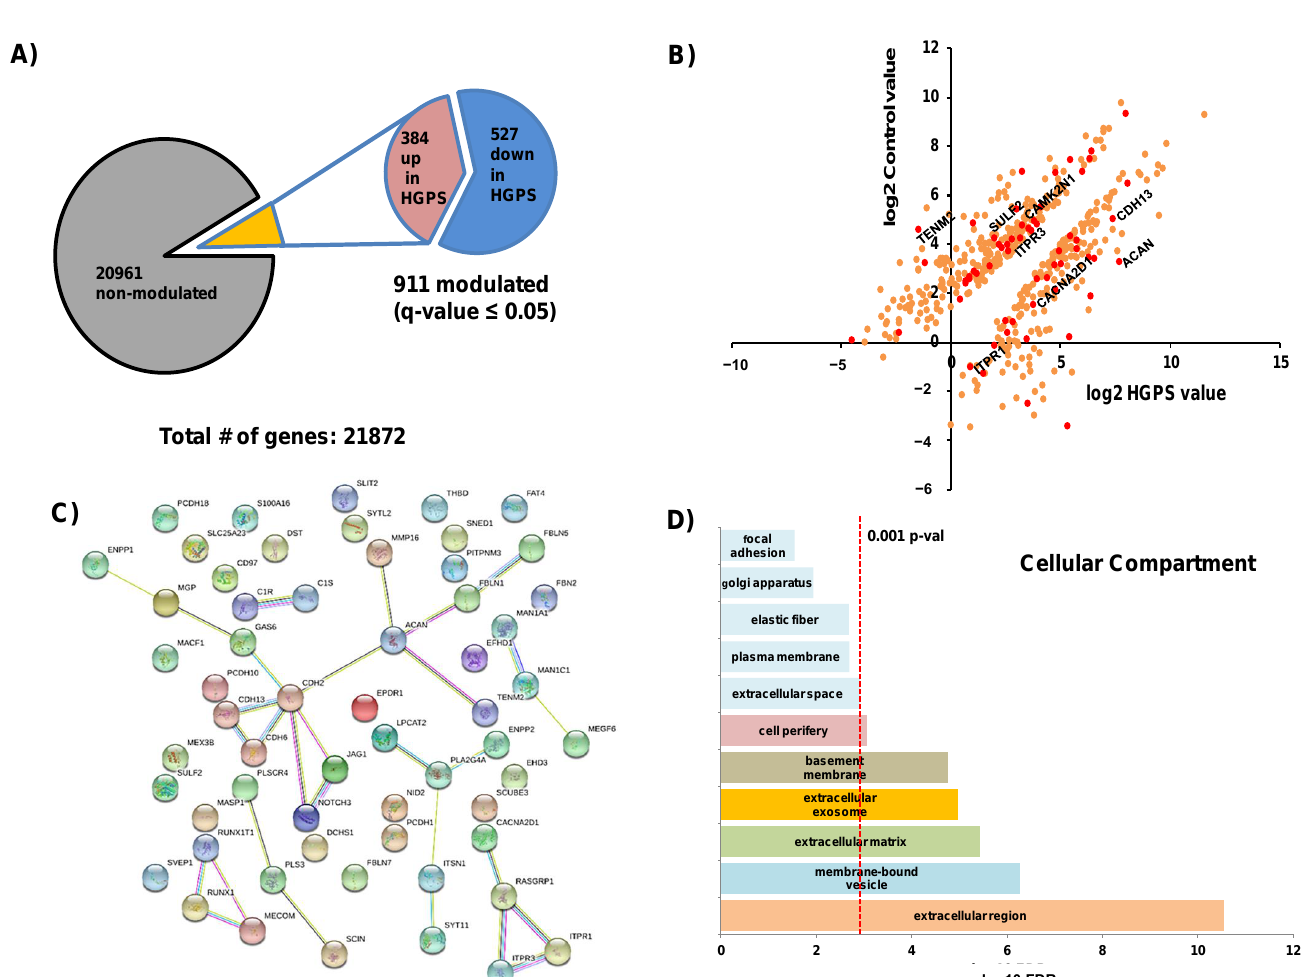
Figure 1. Summary of the massive genomic analysis (RNAseq). ( A ) Summary of the NGS showing the 21,872 different quantified transcripts. Of these, 911 were considered to be significantly modulated, with q -values ≤ 0.05. ( B ) Representation of the values for the 911 significantly modulated transcripts and those coding for Ca 2+ flux-related proteins (in red). ( C ) String 10.1 pathway analysis for the Ca 2+ flux-related transcripts showing the interaction networks. ( D ) Statistical analysis shows that most of those transcripts codify for extracellular and membrane-bound (vesicle/exosome)